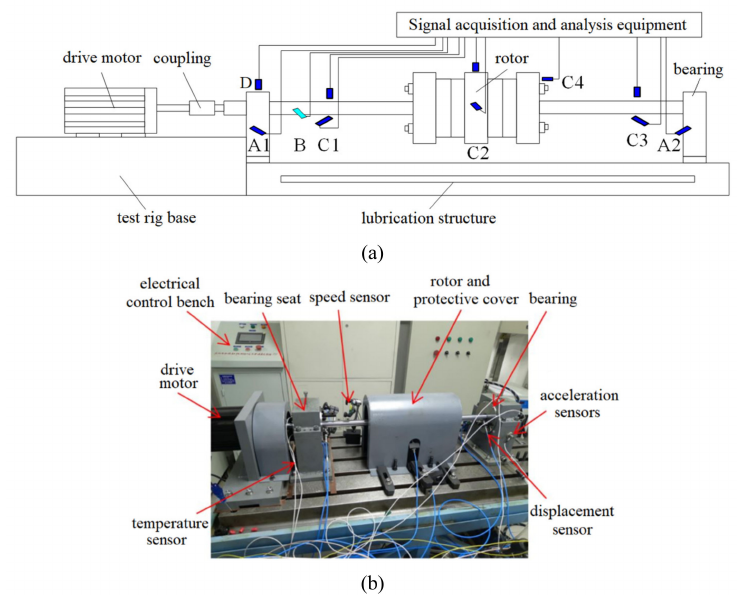
Figure 17. The structure, sensor arrangement and actual picture of the test rig. ( a ) Test rig composition and sensors arrangement; ( b ) Actual picture of the experimental